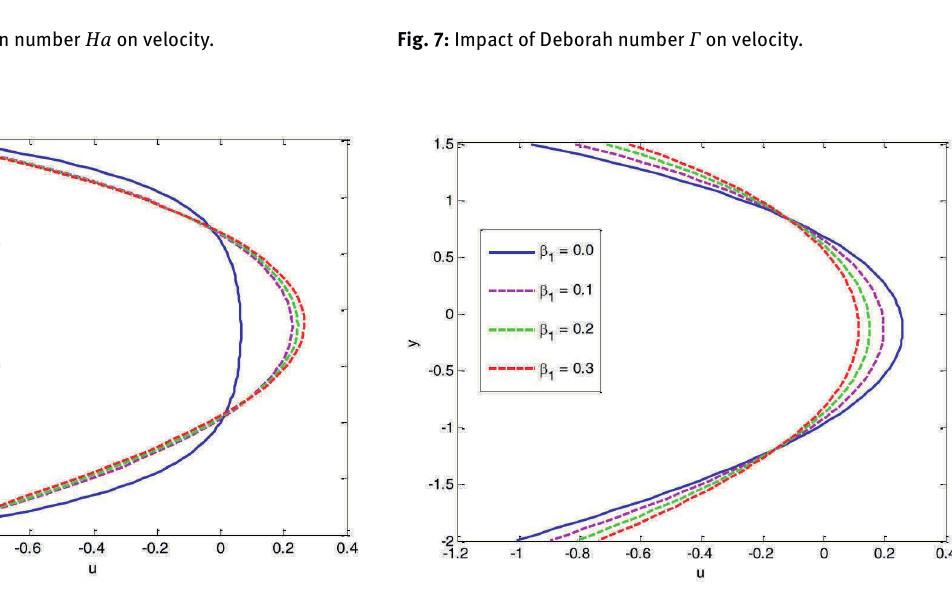
Fig. 5: Impact of porosity parameter K on velocity.